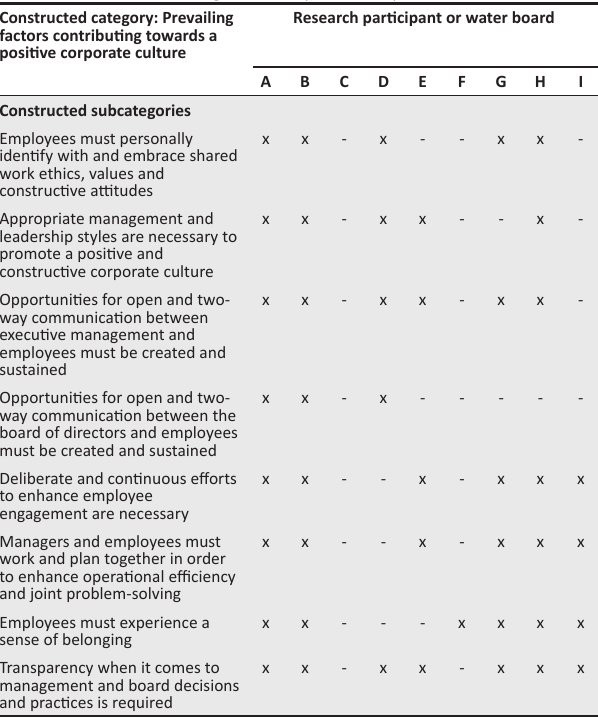
Research participant or water board